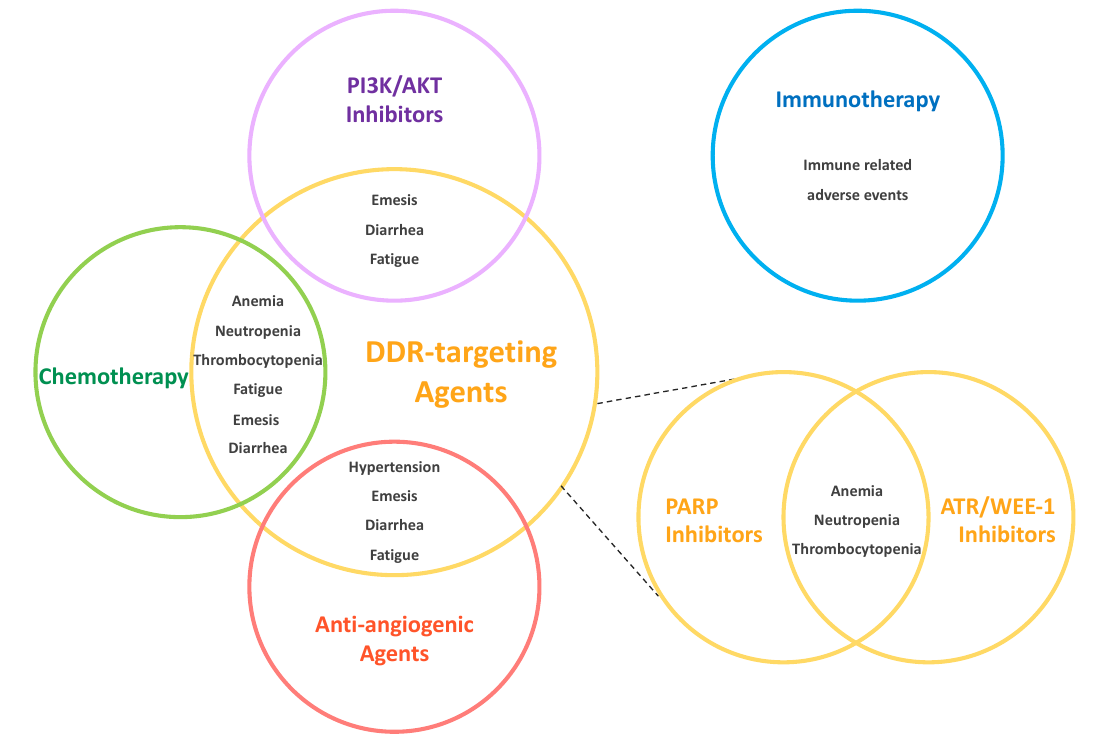
Figure 3. Potential overlapping toxicities of DDR-targeting agent combinations. The circles represent the different class of drugs, and the overlapping sections include the shared toxicities of these molecules, as reported in clinical trials. Immunotherapy did not show significant overlapping adverse events, therefore is represented away from DDR-targeting agents (blue circle, on the upper right). Combinations of different DDR-targeting agents (i.e., PARP inhibitors and ATR or WEE-1 inhibitors) present a significant overlap of hematological toxicities (smaller yellow circles, on the bottom right). Figure Legend: AKT: Protein Kinase B; ATR: Ataxia Telangiectasia and Rad3-Related Protein; DDR: DNA Damage Repair; PARP: Poly-ADP-Ribose-Polymerase; PI3K: Phosphatidyl Inosytol-3 Kinase; WEE1: G2 Checkpoint Kinase (WEE1). Table 3. Comparison of toxicities between experimental and control arm in selected randomized trials of DDR-targeting agent